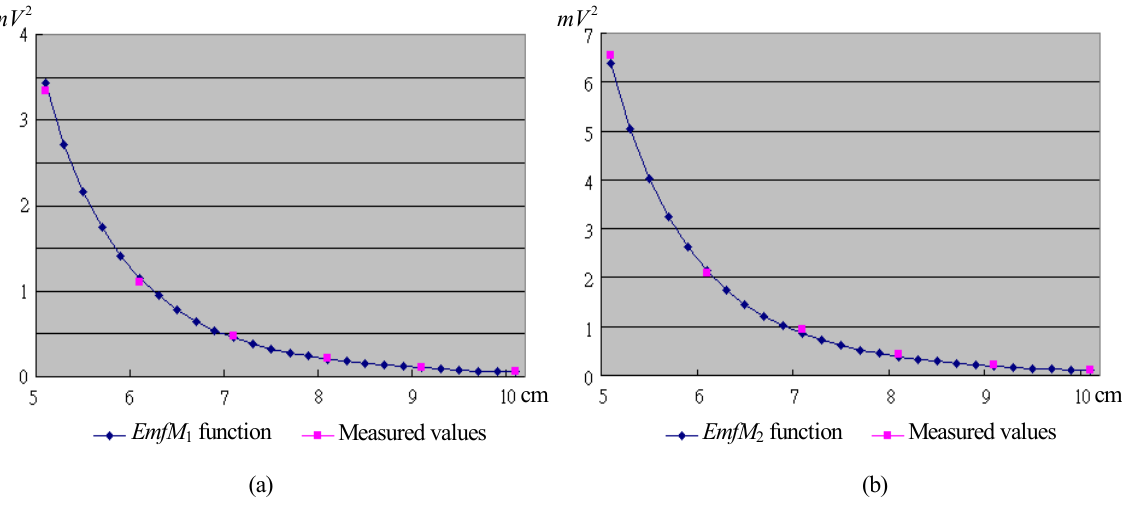
Figure 9. The power Emf function versus the measured values for: (a) EmfM in the linear movement